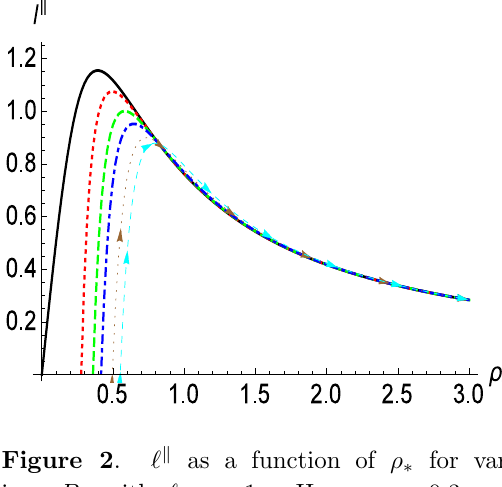
Figure 2 . ‘ k as a function of (cid:26) (cid:3) for var- ious B , with ‘ c = 1. Here c = 0 : 3 and (solid, black), (dot, red), (dash, green), (dot- dash, blue), (arrow-dot, brown) and (arrow- dash, cyan) curves correspond to B = 0, 0 : 1, 0 : 2, 0 : 3, 0 : 5 and 0 : 7 respectively. In units